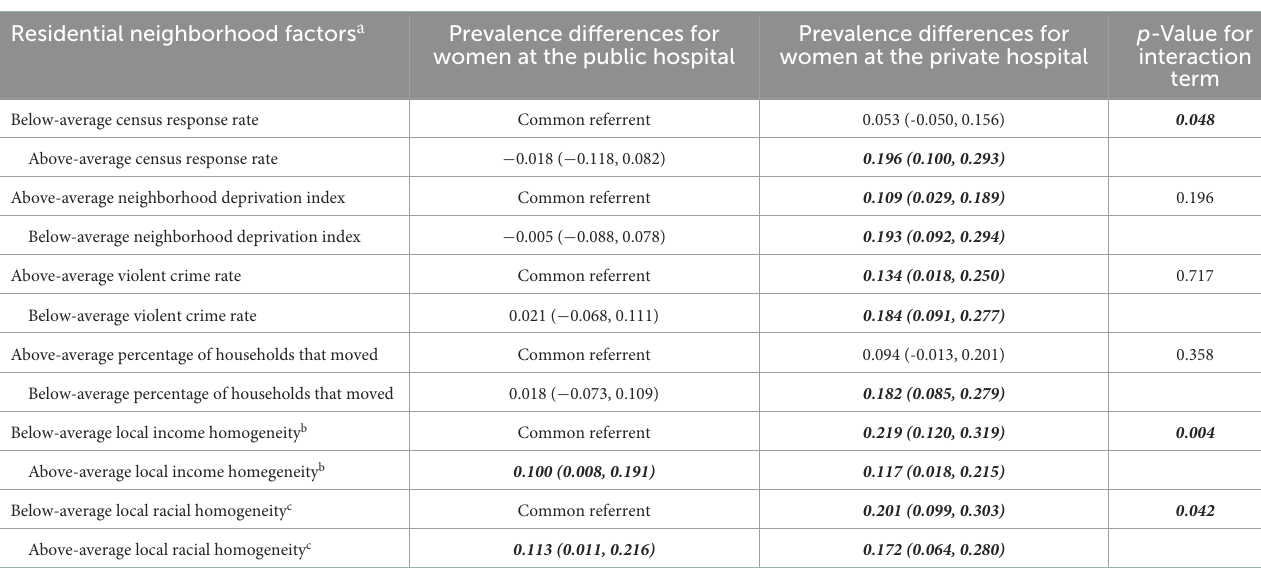
TABLE 4 Joint effects of maternal recruitment hospital and residential neighborhood factors on prevalence of a Lactobacillus (non- iners )—dominant vaginal